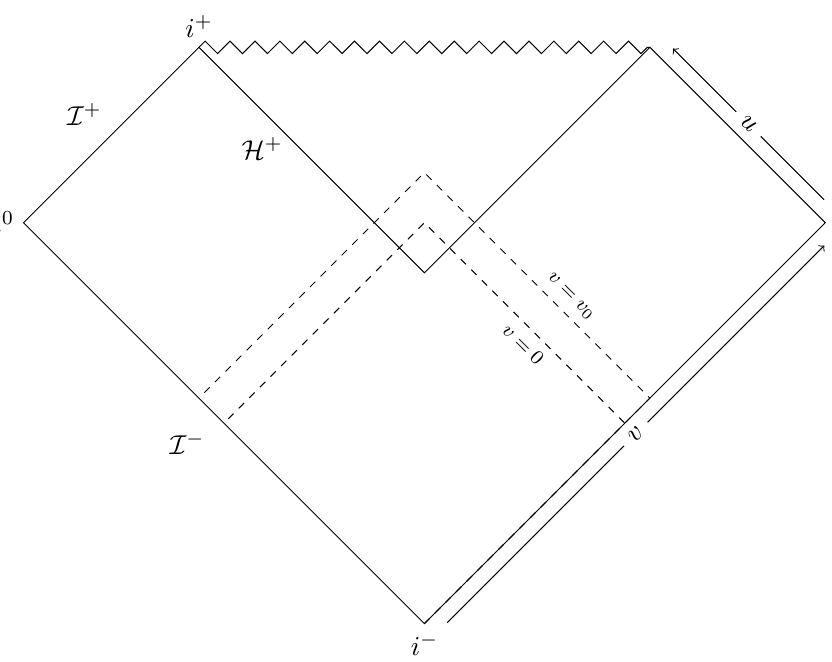
Figure 1 . Penrose diagram of the Vaidya black hole formed by a collapsing shell of a null shockwave at v = 0. Another null shockwave is sent at a later advanced time v = v 0 . Spacelike infinity is denoted by i 0 while i + /i − is the future/past timelike